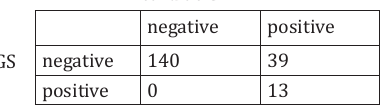
Sensitivity, specificity, positive and negative predictive values of cardiac CT: 2016–2020